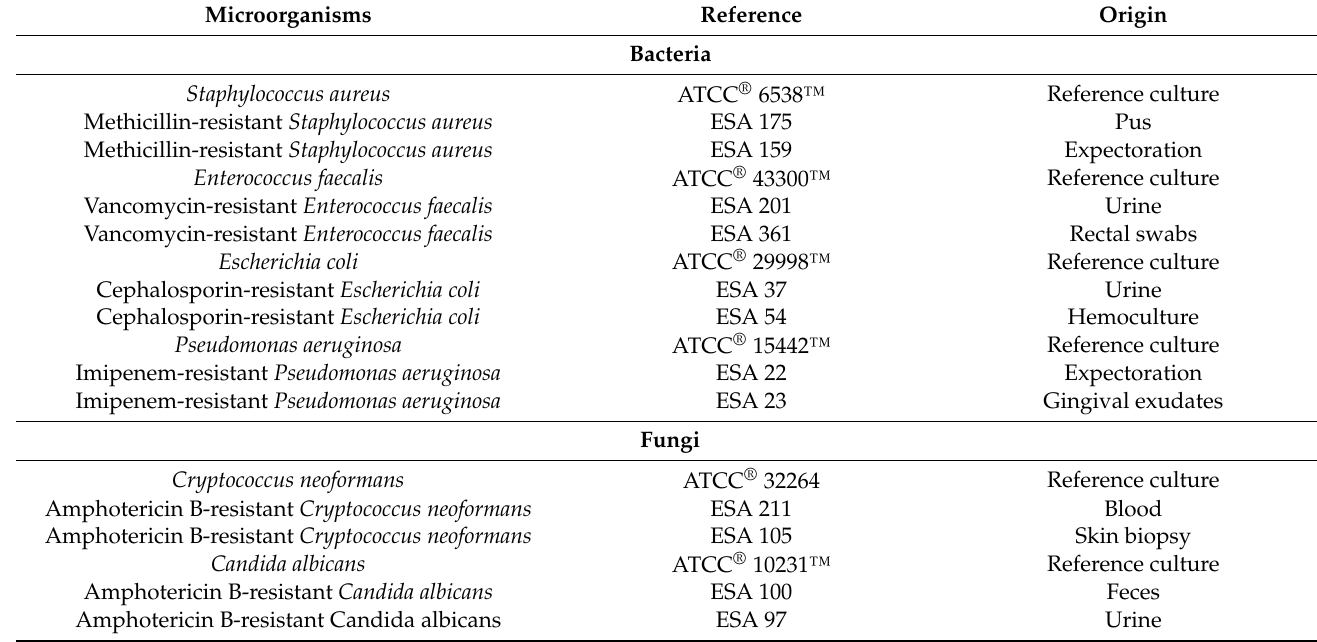
Table 1. Strains of microorganisms used to test the antimicrobial activity of EEP-M and